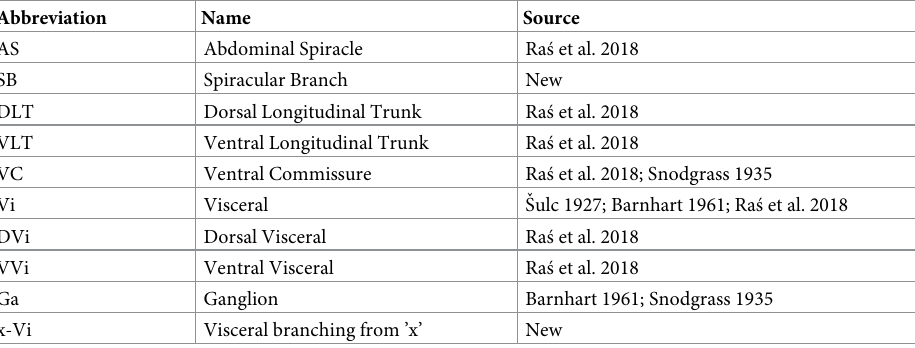
Table 1. Tracheal branching abbreviations and